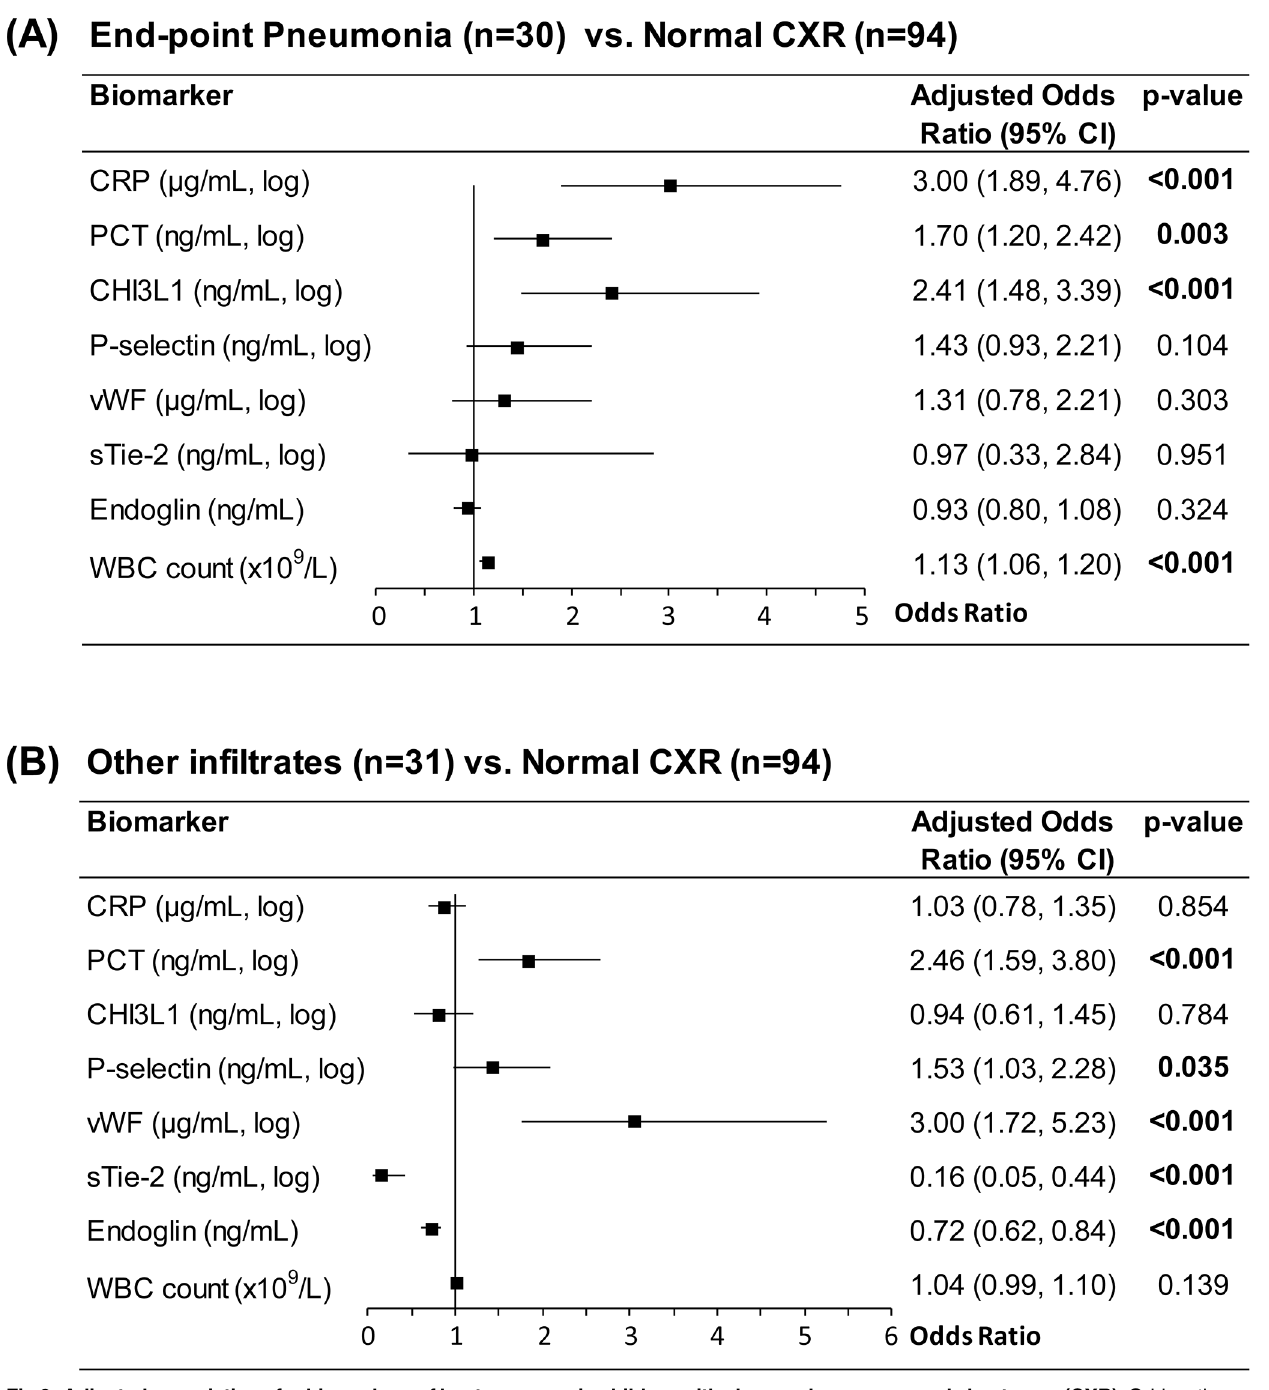
Fig 3. Adjusted associations for biomarkers of host response in children with abnormal versus normal chest x-ray (CXR). Odds ratios were calculated comparing groups using multivariate logistic regression, adjusting for statistically significant demographic and clinical differences between groups. All markers except endoglin and WBC were log transformed since distributions were non-normal. Forest plots show odds ratio point estimates (black squares) and 95% confidence intervals (lines). (A) Odds ratios for end-point pneumonia versus normal CXR, adjusted for age and sex. (B) Odds ratios for other infiltrates versus normal CXR, adjusted for temperature. CHI3L1, Chitinase 3-like-1; CRP, C-reactive protein; CXR, chest x-ray; PCT, procalcitonin; sTie-2, soluble Tie-2; vWF, von Willebrand Factor; WBC, white blood cell.